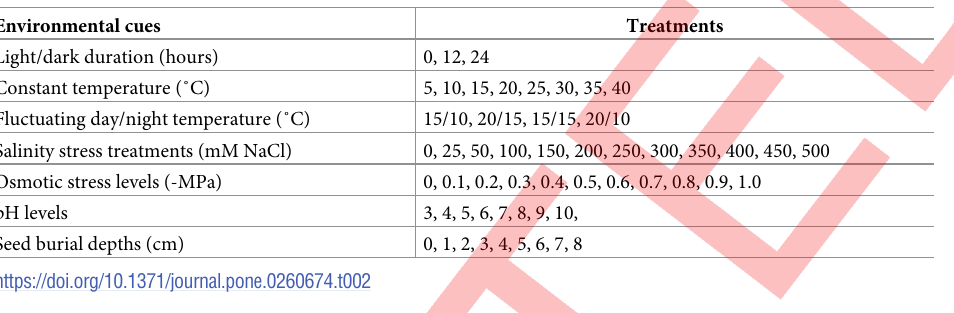
Table 2. Different environmental cues and their levels used to study seed germination biology of Conyza suma- trensis populations collected from varying climatic